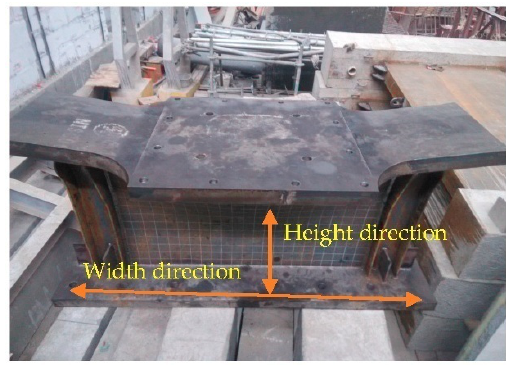
Figure 29. Vertical deformation of specimen 2.